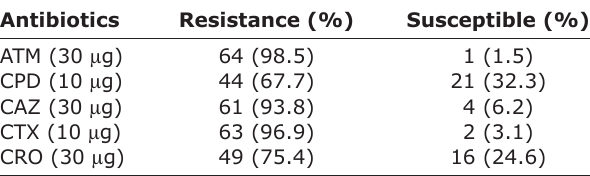
Table-4: Susceptibility of E. coli to beta-lactam